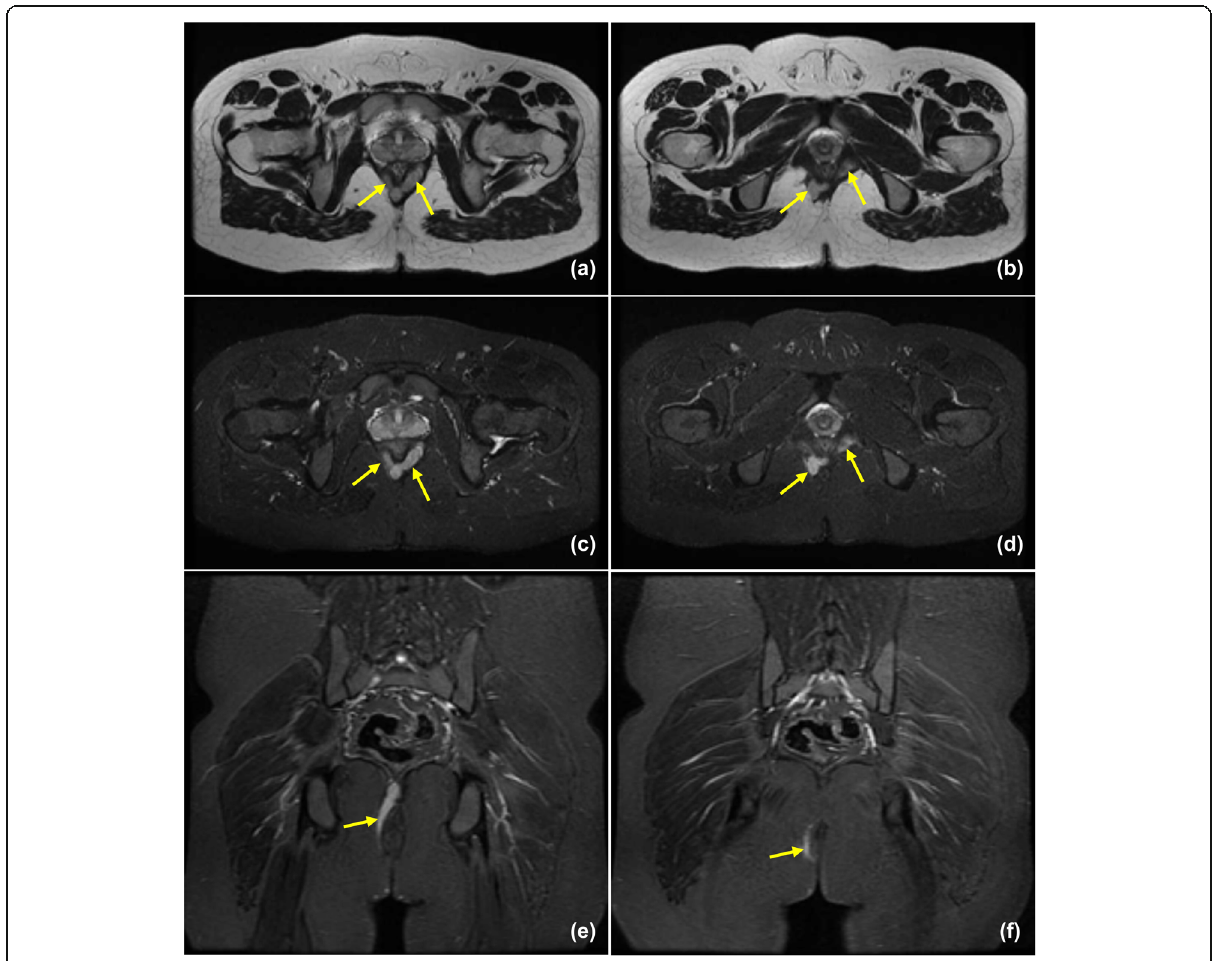
Fig. 14 MR pelvis images of a transsphincteric fistula with bilateral intersphincteric extension. a , b T2W axial, c , d FS T2W axial, and e , f FS T2W coronal images showing the course of track and extension (yellow